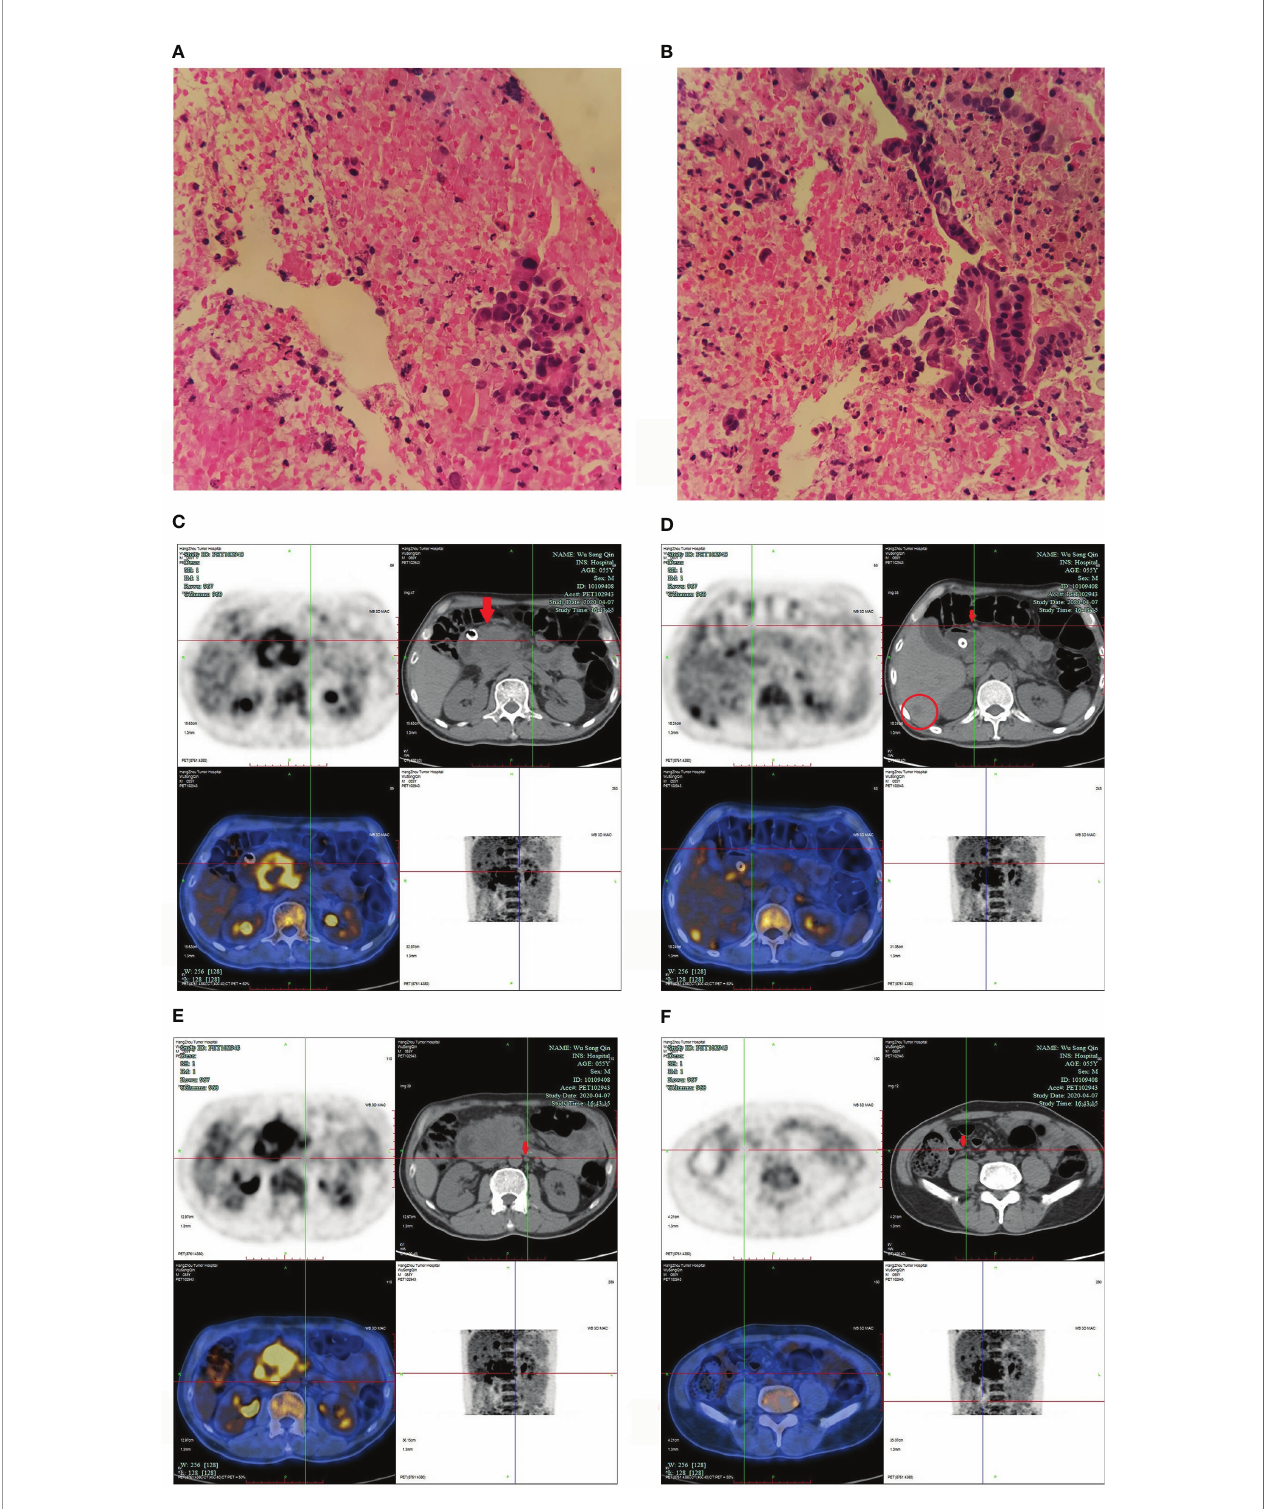
FIGURE 1 | (A, B) pancreatic ductal adenocarcinoma. (A) 200X, (B) 400X. The pancreatic head puncture smear showed signi fi cant atypical epithelial mass, irregular nuclei, which was consistent with the changes of adenocarcinoma. (C – F) PET/CT images in April 2020. (C) showed a 6.0cm *6.0 cm mass in pancreatic head (arrow); (D) con fi rmed enlarged lymph nodes in pancreatic head (arrow), and low-density shadows in liver (within cycle); panels (E, F) revealed enlarged multiple lymph nodes in different sizes in retroperitoneum